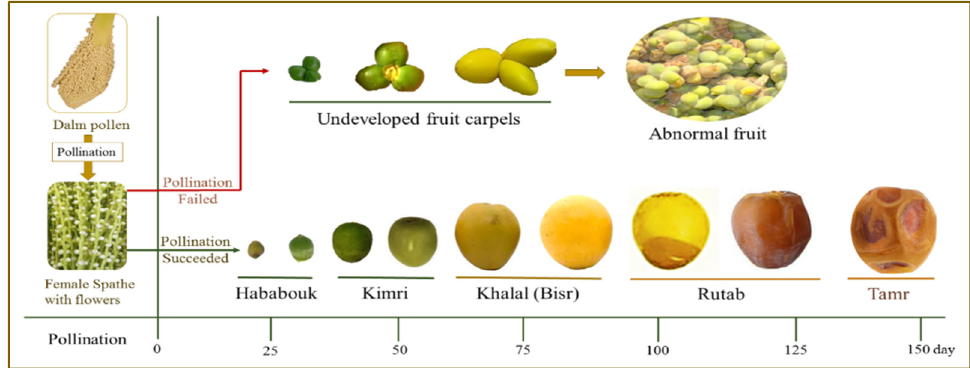
Figure 1. Development stages of date palm fruit after pollination.